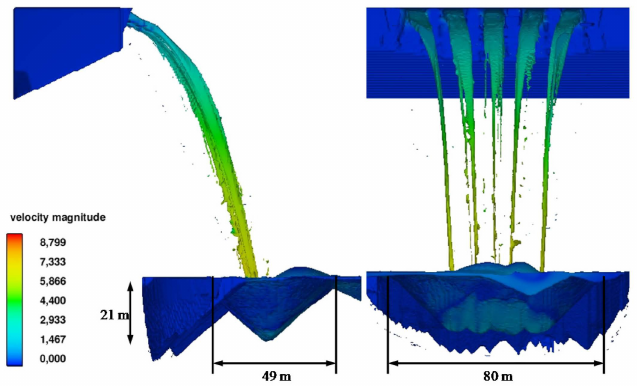
Figure 11. Scour bowl due to the free surface weir jet. Bilayer simulation: alluvial 24 m and weathered rock 10 m (Units in m/s. Froude scale 1:50. Prototype impingement velocity = 6.1 ˆ 50 1/2 = 43.13 m/s).